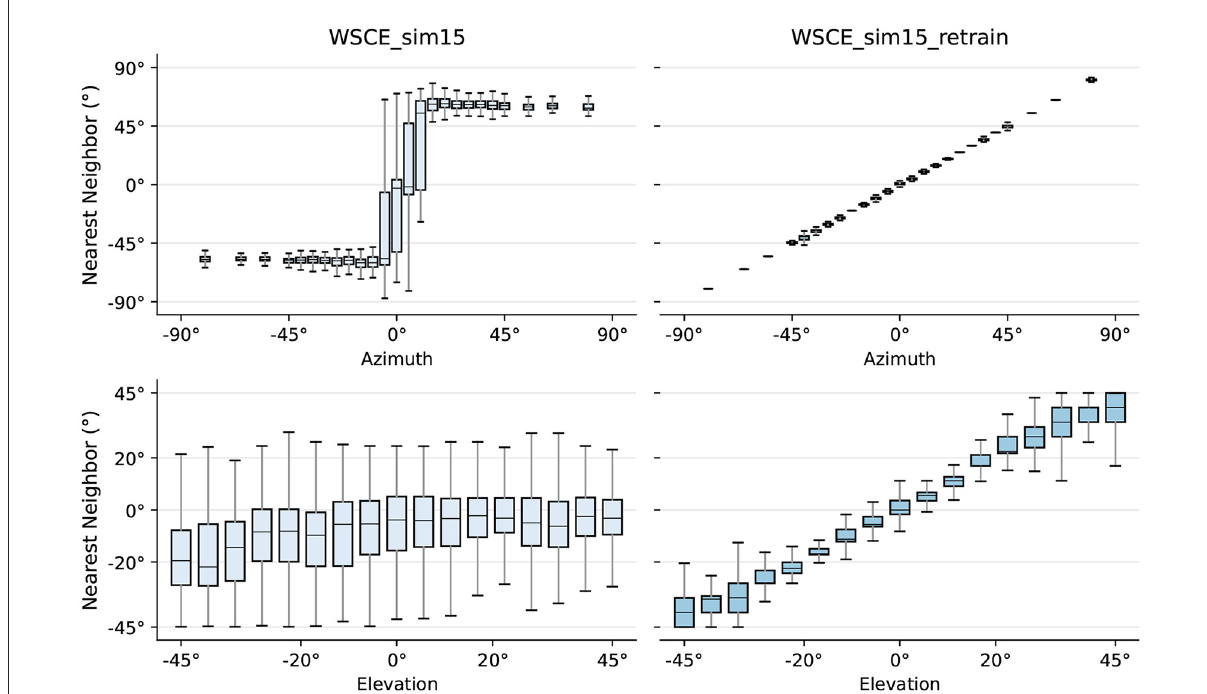
FIGURE8 True locations of sources in the testing set versus the locations of their respective nearest neighbor in the training set for WSCE_sim15 and WSCE_sim15 retrained with 33 different HRTFs other than the once used in generating test recordings (i.e., WSCE_sim15_retrain).